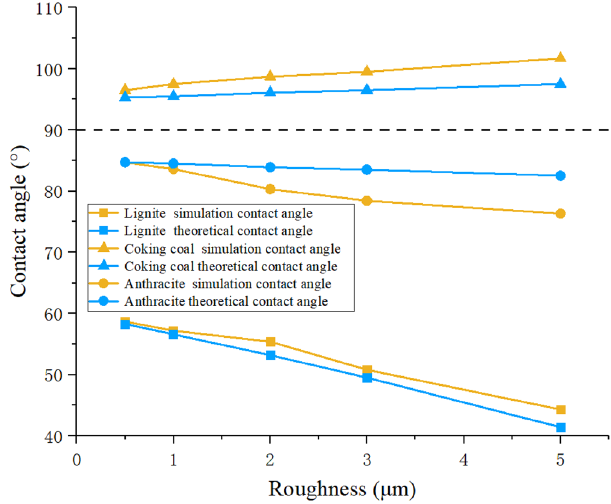
Figure 14. Comparison of simulated and theoretical contact